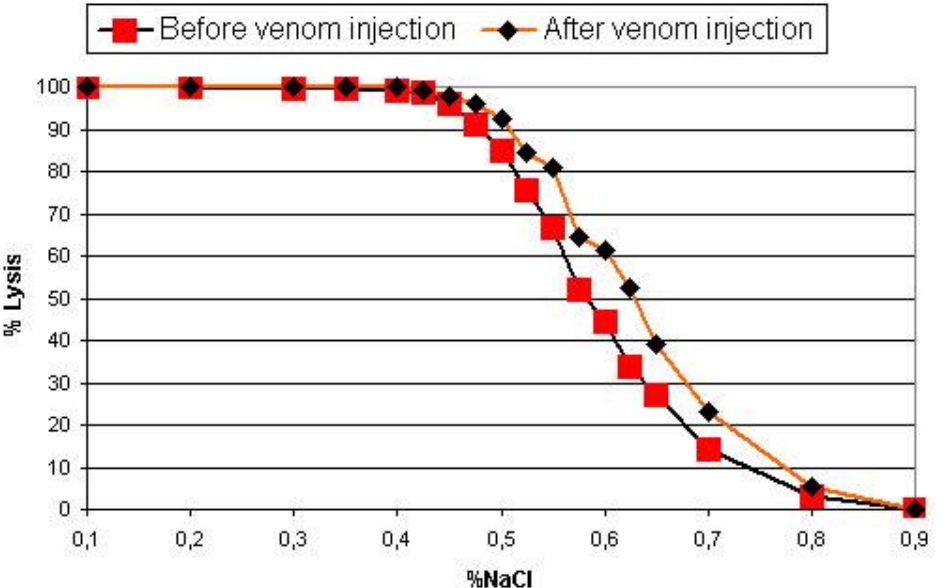
Figure 2: In vivo effect of O. doriae venom (0.5 mg/kg, IV) on the osmotic fragility of RBCs after incubation for 24